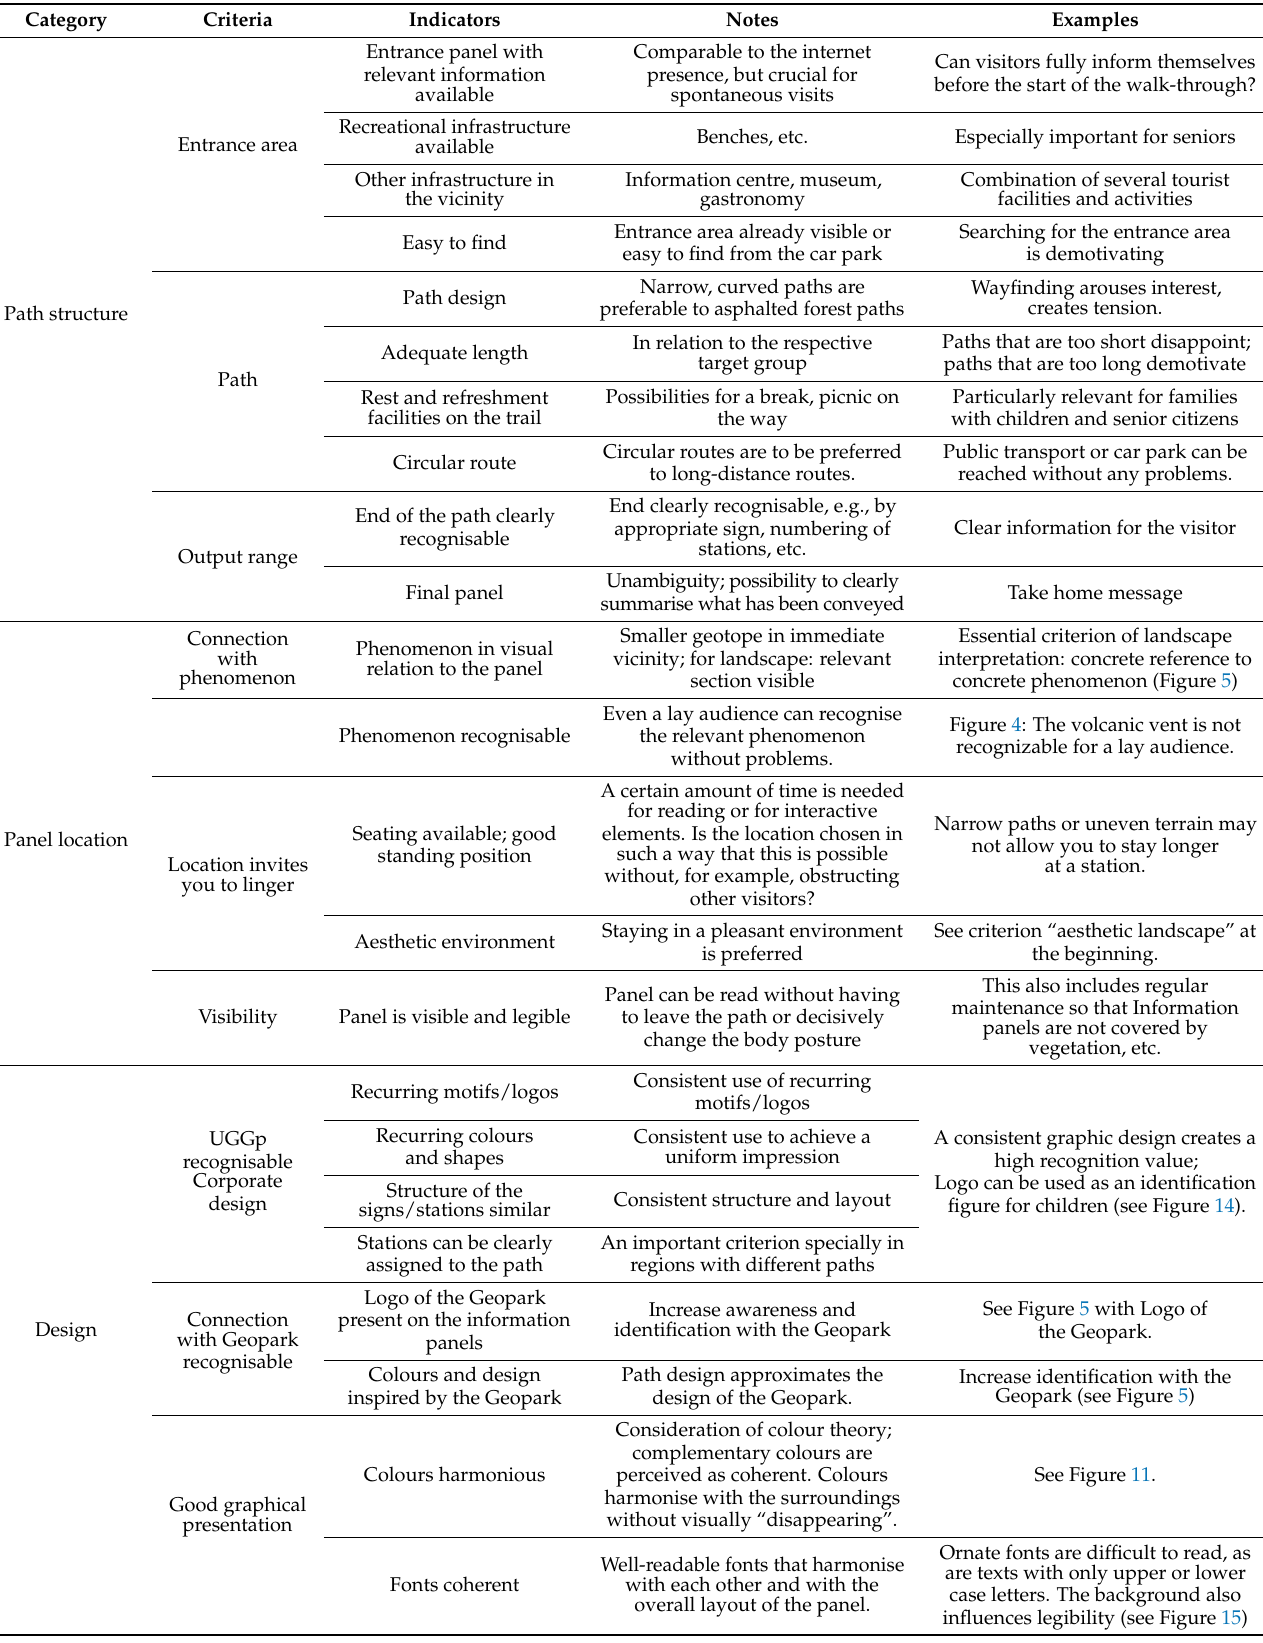
Figure 4: The volcanic vent is not recognizable for a lay